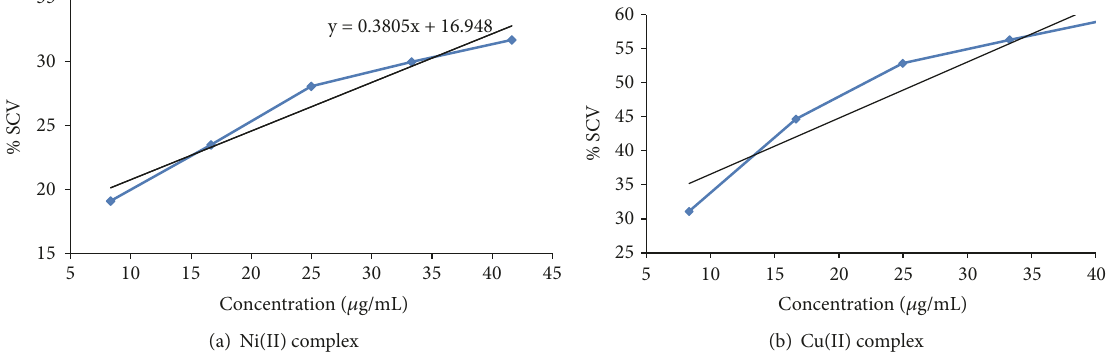
Figure 7: DPPH scavenging activity of Ni(II) and Cu(II) complexes.